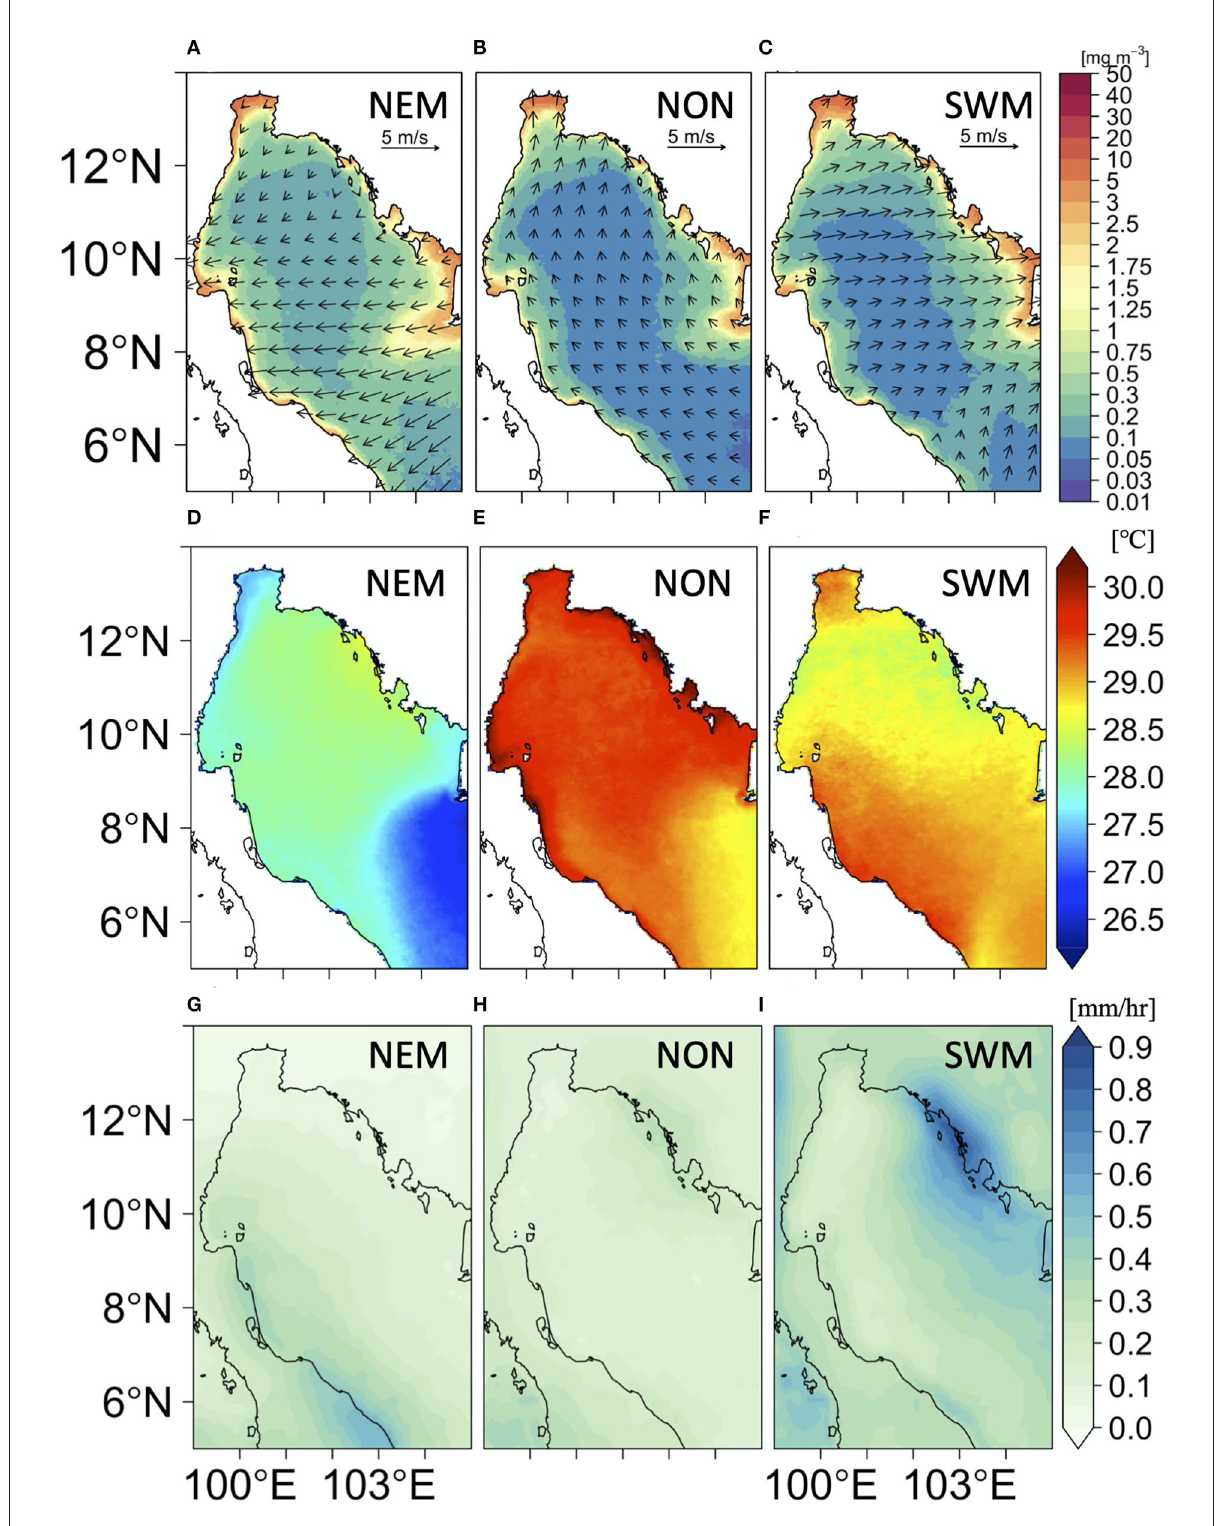
FIGURE3 Seasonal climatology of chl-a with sea surface wind (A–C) , SST (D–F) , and precipitation (G–I) .